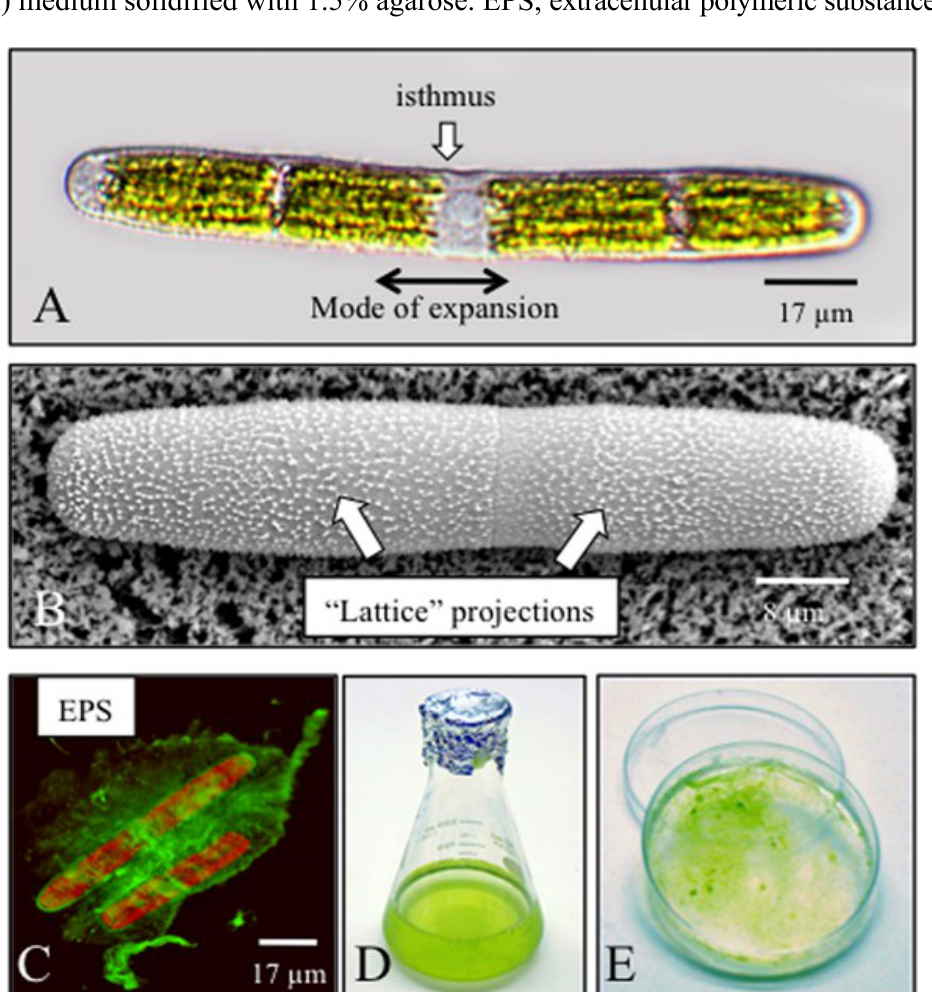
Figure 1. General features of Penium and its cell wall. ( A ) Penium is an elongated cylindrical uni-cell with rounded edges. The central isthmus (“isthmus”) contains the nucleus and is also the focal point of cell wall expansion. New wall polymers are deposited here in a narrow band that, in turn, displaces older cell wall outward toward the poles (“mode of expansion”, arrow); ( B ) variable pressure scanning electron microscopy (VPSEM) image of the cell wall surface showing the numerous projections that form the outer wall lattice (“lattice projections”, arrows); ( C ) Penium also produces a gel-like EPS that attaches to the wall and extends outward (arrow). The cell was labeled with an anti-EPS antibody and viewed with a confocal laser scanning light microscope (CLSM); ( D ) For culturing, cells are grown in flasks of sterile liquid medium; ( E ) cells may also be successfullygrown on agarose-solidified medium. In this image, the cells are growing on cellophane on top of Woods Hole